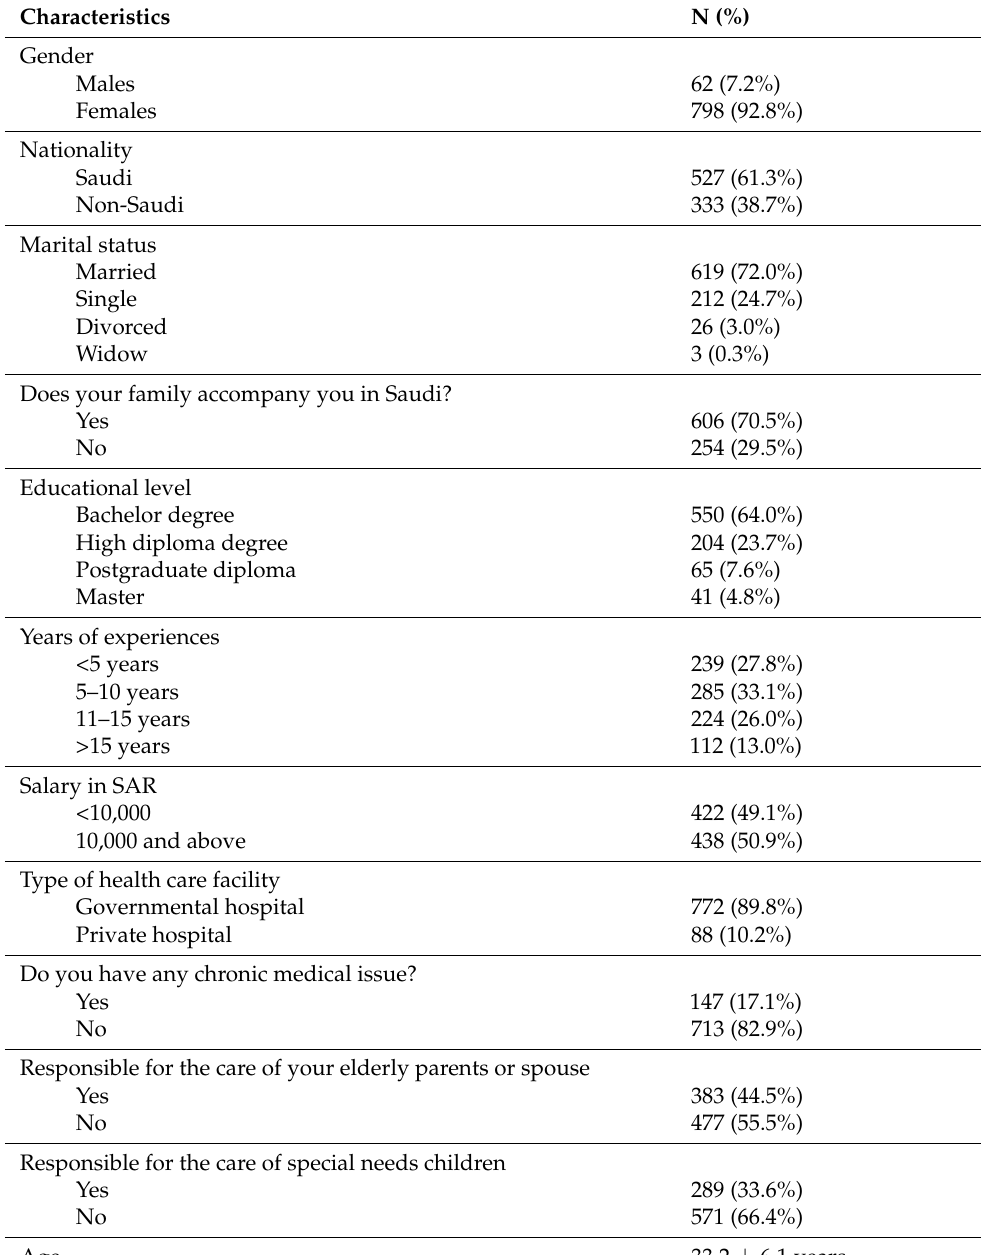
Table 1. Baseline socio-demographic characteristics ( n =